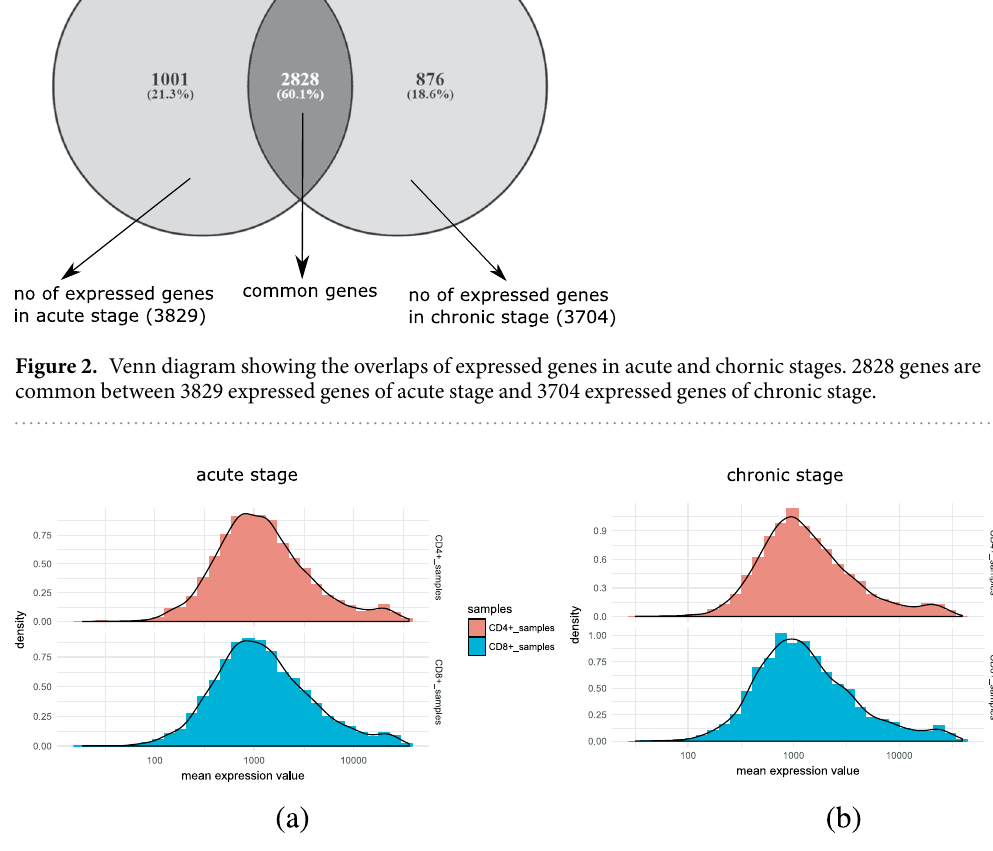
Figure 3. Figure shows the distribution of mean expression values of all expressed genes in CD4 + and CD8 + samples in acute and chronic